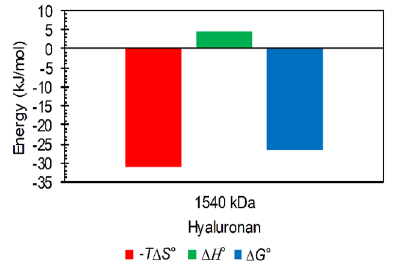
Figure 7. Example of magnitudes of thermodynamic parameters determined from ITC for interactions of arginine dodecamer in hydrochloride form with hyaluronan of molecular weight 1540 kDa in water (25 °C).